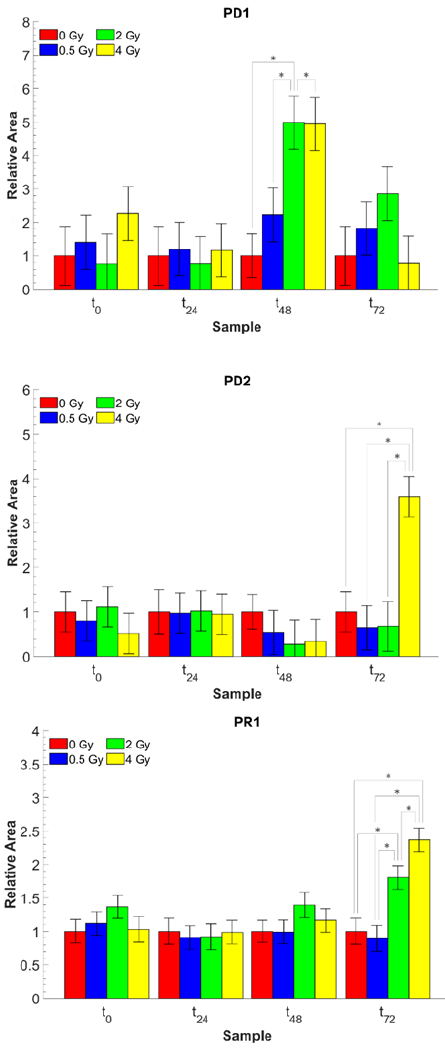
Figure 5. Comparison of the PD1, PD2, and PR1 absorbance area ratios for MCF-10A human breast epithelial cells for different proton doses and different fixation times. See Table 1 for details on the reported ratios (Mean ± SD), which are normalized to the corresponding ratio value of the non-irradiated sample. Asterisks indicate significant differences ( p < 0.05).